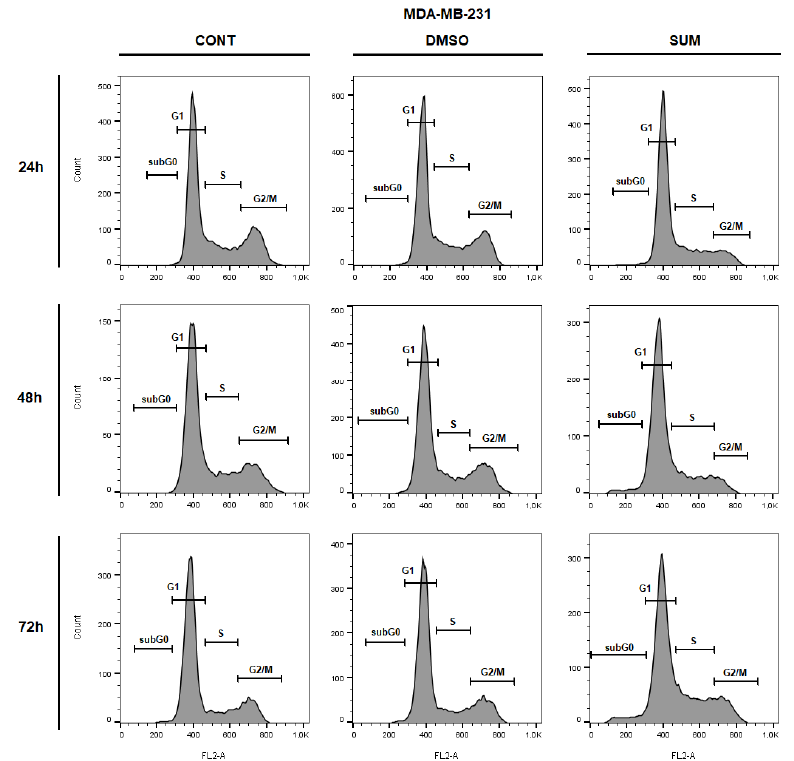
Figure 11. Representative diagrams of cell cycle distribution in MDA-MB-231 cells after SUM treatment (215 µg/mL).